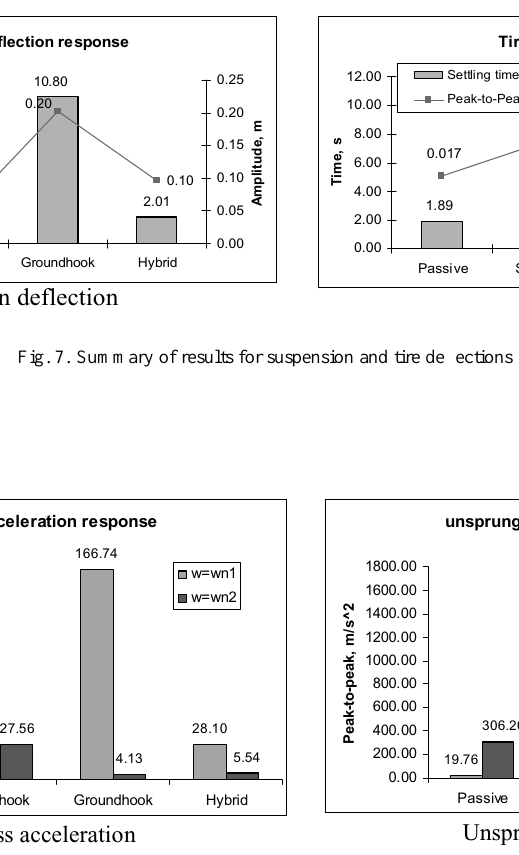
Fig. 8. Peak-to-Peak value for sprung mass and unsprung mass acceleration response.